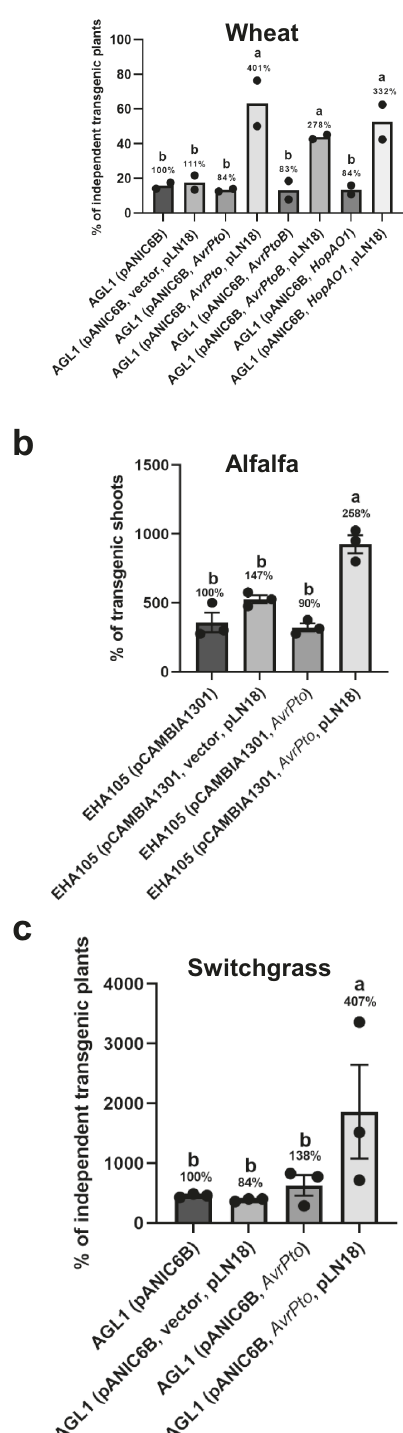
(Fig. 7a – c and Supplementary Fig. 9a). Transformation assays in crop plants using engineered strains expressing HTA1 also showed increased transformation ef fi ciency in wheat, alfalfa, and switchgrass (Fig. 7d – f, Supplementary Fig. 9b and c). These